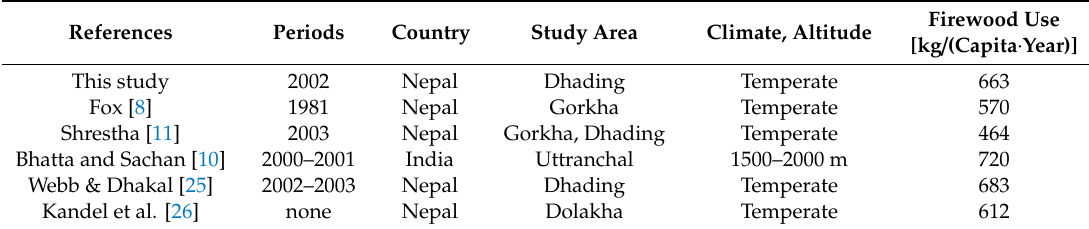
Table 2. Results of previous studies carried out in temperate climatic